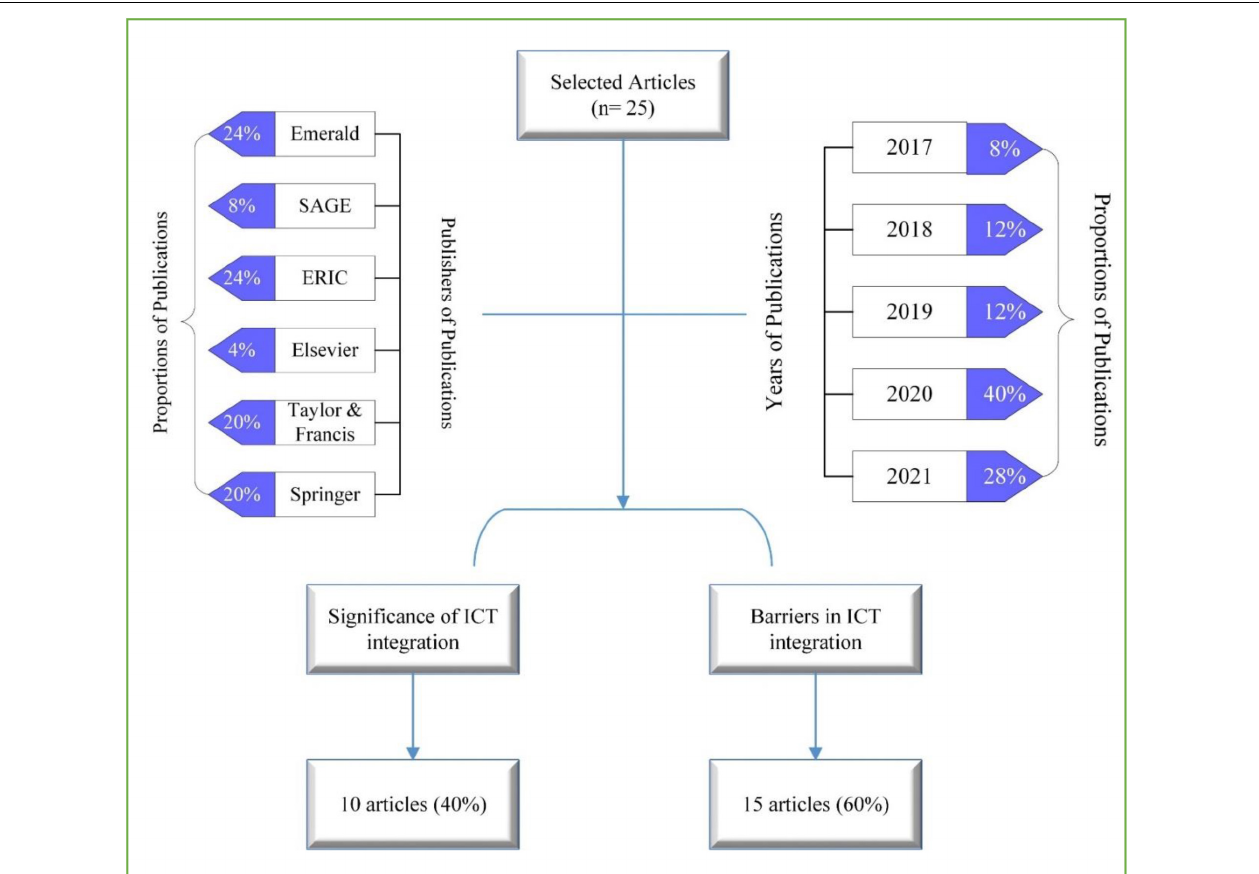
FIGURE 1 | Thematic classification and studied articles by years and